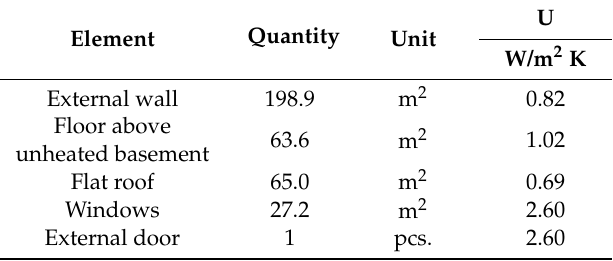
Table 8. The heat transfer coefficients and surfaces of external elements of the two-storey building with a flat roof.